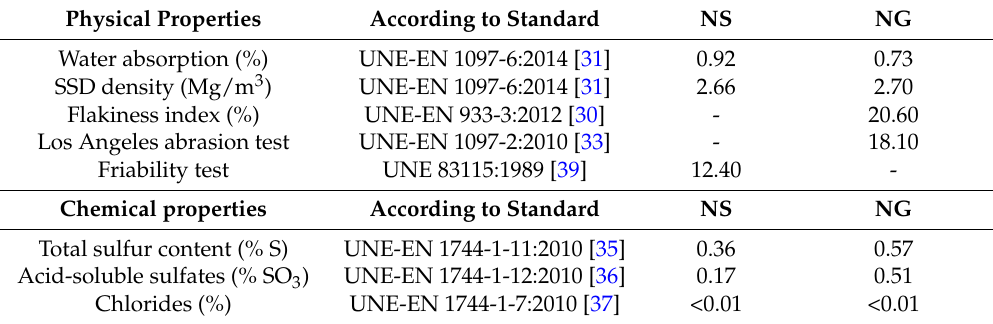
Table 2. Physical and chemical properties of natural aggregates (NA). NS = Natural siliceous sand, NG = Siliceous gravel.